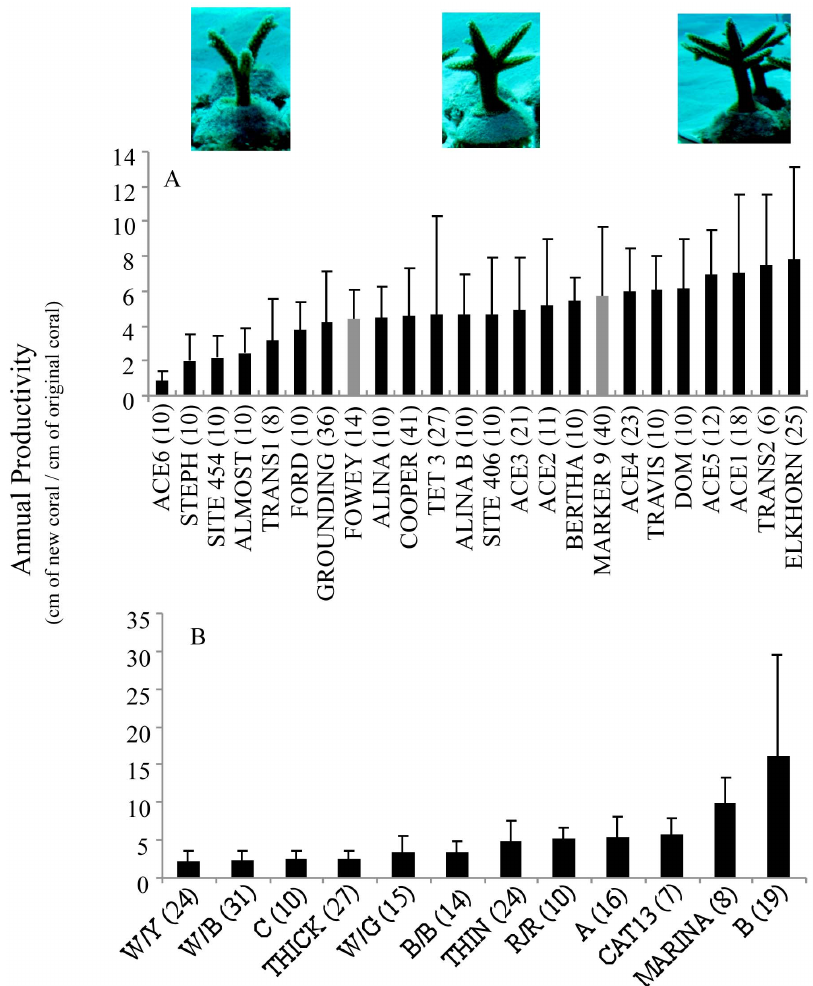
Figure 3. Productivity of staghorn fragments by coral genotype. Annual productivity of staghorn genotypes from Florida (A) and the Dominican Republic (B). Numbers in parentheses are sample sizes for each genotype. Grey bars in (A) are the two genotypes dominated by clade C algal symbionts. All other genotypes, including those in the DR were dominated by clade A. The coral genotype from the DR dominated by clade C was represented by only 3 surviving fragments and thus not included in the analyses. The images are representative of slow- (left), medium- (center), and fast-growing (right) genotypes after 1 year in the nursery. Pair-wise comparisons revealed that only ELKHORN and ACE 6/STEPH had significantly different productivity values in Florida, while only B and W/B/W/Y had significantly different productivity values in the DR (Tukey-Kramer test, p , 0.05).